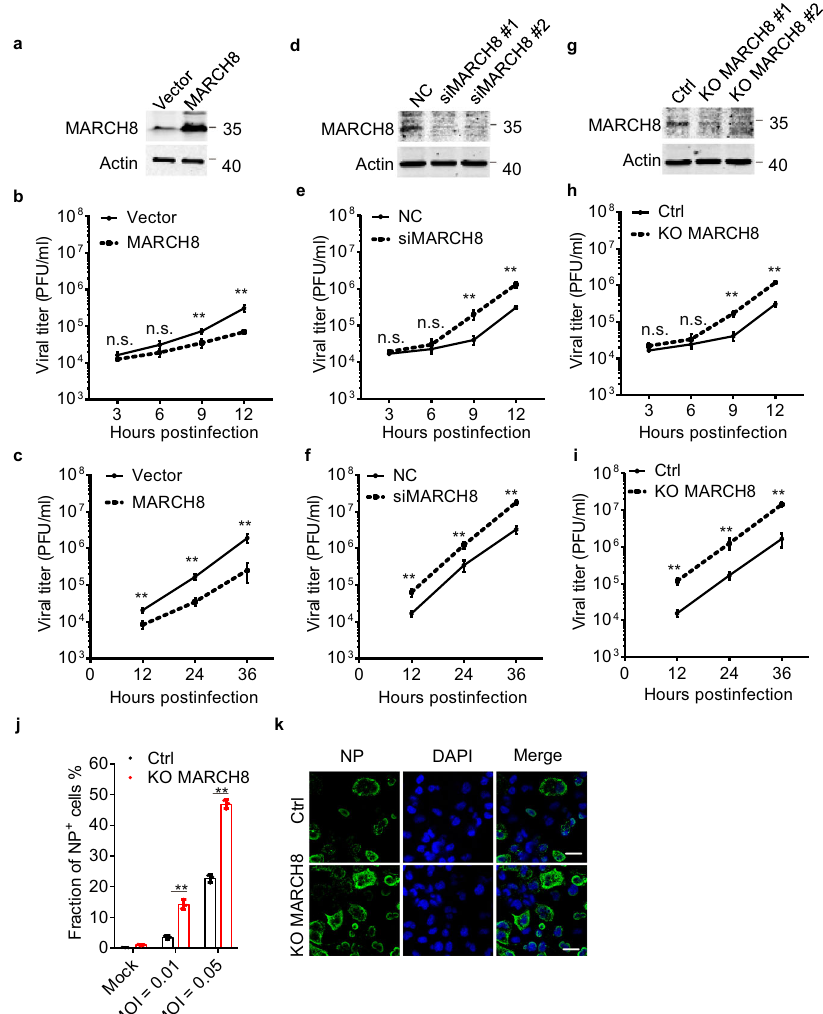
Fig. 2 MARCH8 inhibits IAV replication in vitro. a A549 — Vector and A549 — MARCH8 cells were constructed and MARCH8 expression determined by western blotting. b , c A549 — Vector and A549 — MARCH8 cells were infected with WSN virus for indicated times. Viral titers of supernatants were quanti fi ed by plaque assay. d A549 cells were transfected with siRNA targeting MARCH8. MARCH8 expression was examined by western blotting. e , f A549 cells transfected with siNC or siMARCH8 were infected with WSN virus. Viral titers of supernatants were quanti fi ed by plaque assay. g The endogenous MARCH8 in A549 cells was knocked out through the use of lentiviral CRISPR-Cas9. MARCH8 expression was determined by western blotting. h , i Control (Ctrl) or MARCH8 -knockout (KO MARCH8 ) A549 cells were infected with WSN virus. Supernatants were harvested and viral titers were detected at indicated times. b , e , h MOI = 1. c , f , i MOI = 0.002. j , k Ctrl and KO MARCH8 A549 cells were infected with WSN virus. At 24h post infection, viral NP protein expression was measured by fl ow cytometry ( j ) and confocal microscopy ( k ). Scale bar, 200 μ m. Data represent averages of independent biological replicates and are presented as means±SD ( b , e , and h , n = 4, c , f , i , and j , n = 3). ** P <0.001, n.s., not signi fi cant, unpaired two-tailed Student t -test, without any adjustments for multiple